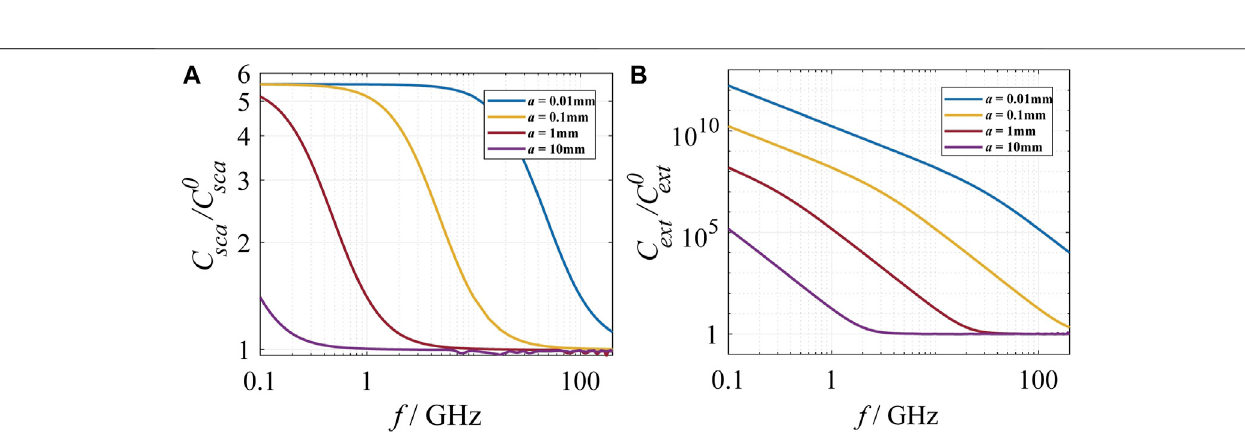
FIGURE 4 | The in fl uence of the size of the particles on the scattering/extinction cross sections of a single charged particle. The radii of particles are set to a (cid:1) 0 . 01 , 0 . 1 , 1 , 10mm. (A) Theratio ofscattering cross section ofa charged particletothat ofan uncharged one. (B) The ratioofextinction cross section of acharged particle to that of an uncharged